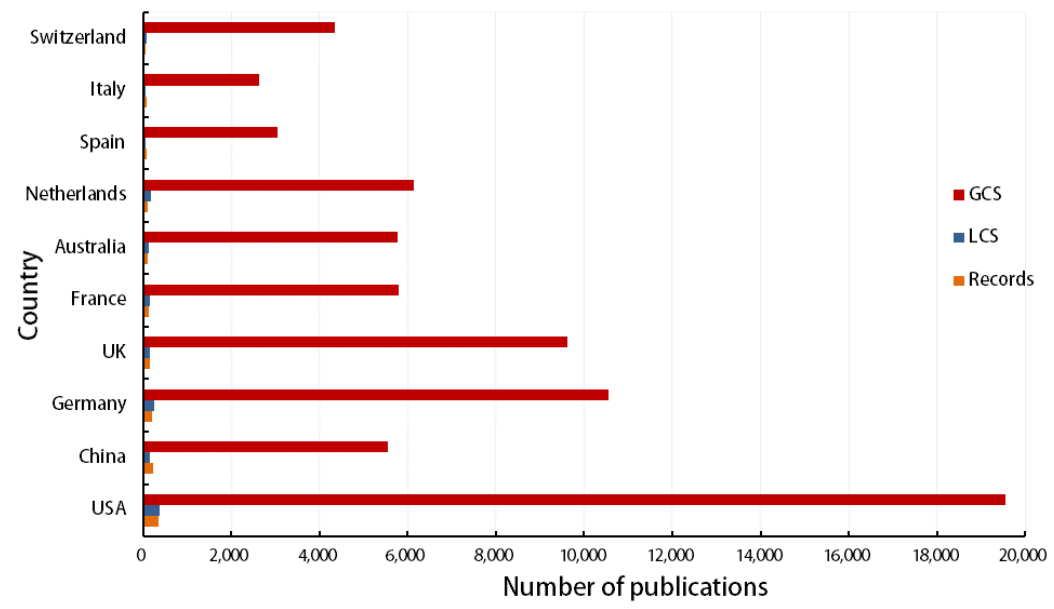
Figure 3. Top 10 countries with publications on agricultural land function.